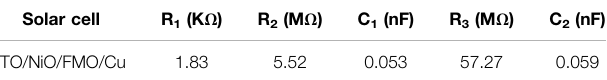
> R Table 2 indicate that R 3 2 by an order of magnitude and so we can infer that the ITO/NiO/FeMnO 3 /Cu device exhibits a relative high recombination resistance which can explain the high V oc value, but on